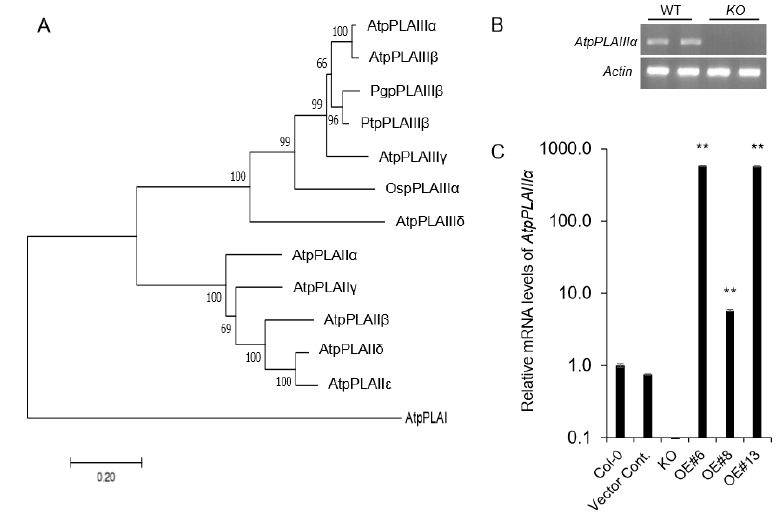
Figure 1. Phylogenetic analysis, T-DNA insertion knockout mutant, and overexpression lines of AtpPLAIIIα gene. ( A ) Phylogenetic tree of AtpPLAs, OspPLAIIIα, PgpPLAIIIβ, and PtpPLAIIIs proteins. The phylogenetic tree was constructed using the Mega7 program (7.0.26 version, neighbor- joining method). At, Arabidopsis thaliana; Os, Oryza sativa; Pg, Panax ginseng; Pt, Populus trichocarpa . ( B ) RT-PCR of AtpPLAIIIα gene expression in wild-type (WT) and AtpplaIIIα knockout ( KO ) lines. β-Actin was used as internal control. ( C ) Transcript levels of AtpPLAIIIα genes in KO and overexpression ( OE) lines as measured by qRT-PCR. Data represent the mean ± SE of three independent replicates at P < 0.05 (*) and P < 0.01 (**), respectively.